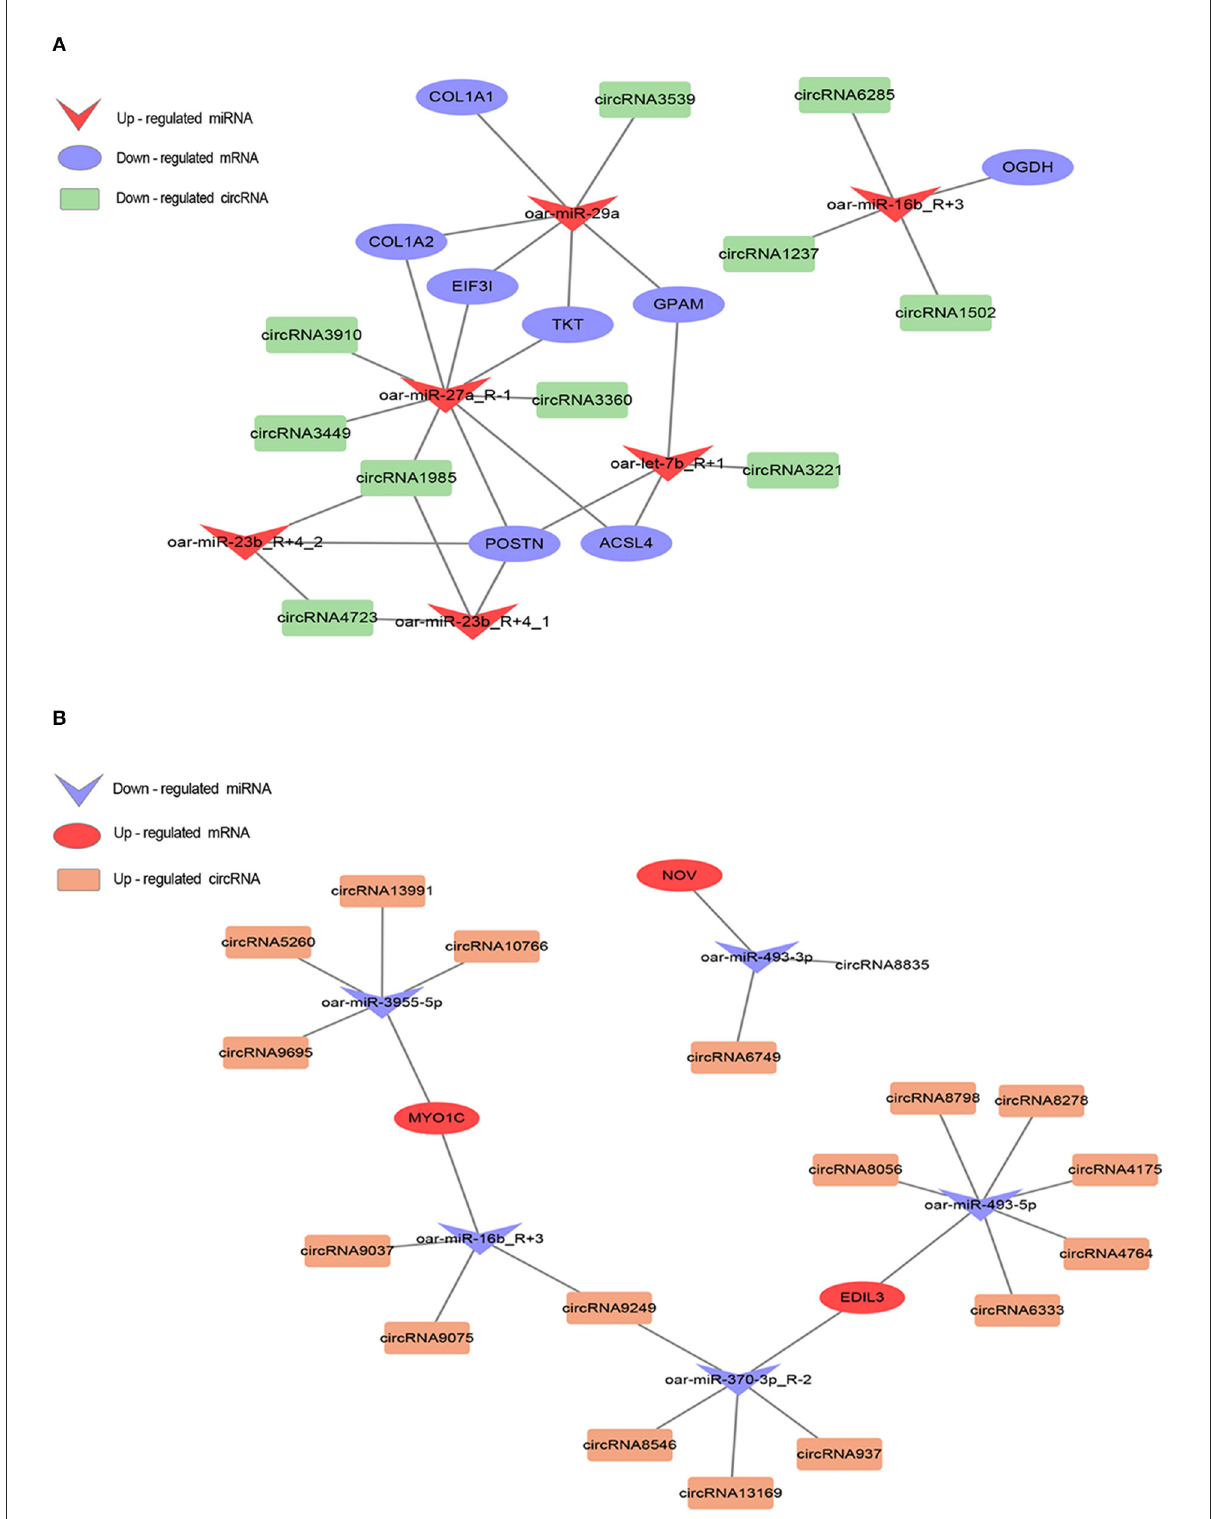
FIGURE7 ceRNA regulatory network analysis in sheep tail fat. (A) Down-up-down mode. (B) Up-down-up mode. The shapes represent different RNAs and the colors represent different regulations.